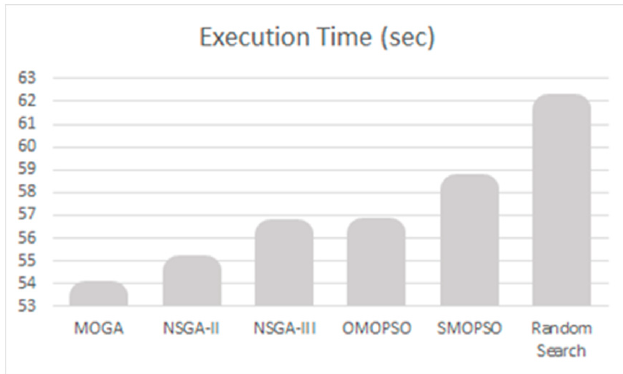
Figure 10. Average execution time for each algorithm.